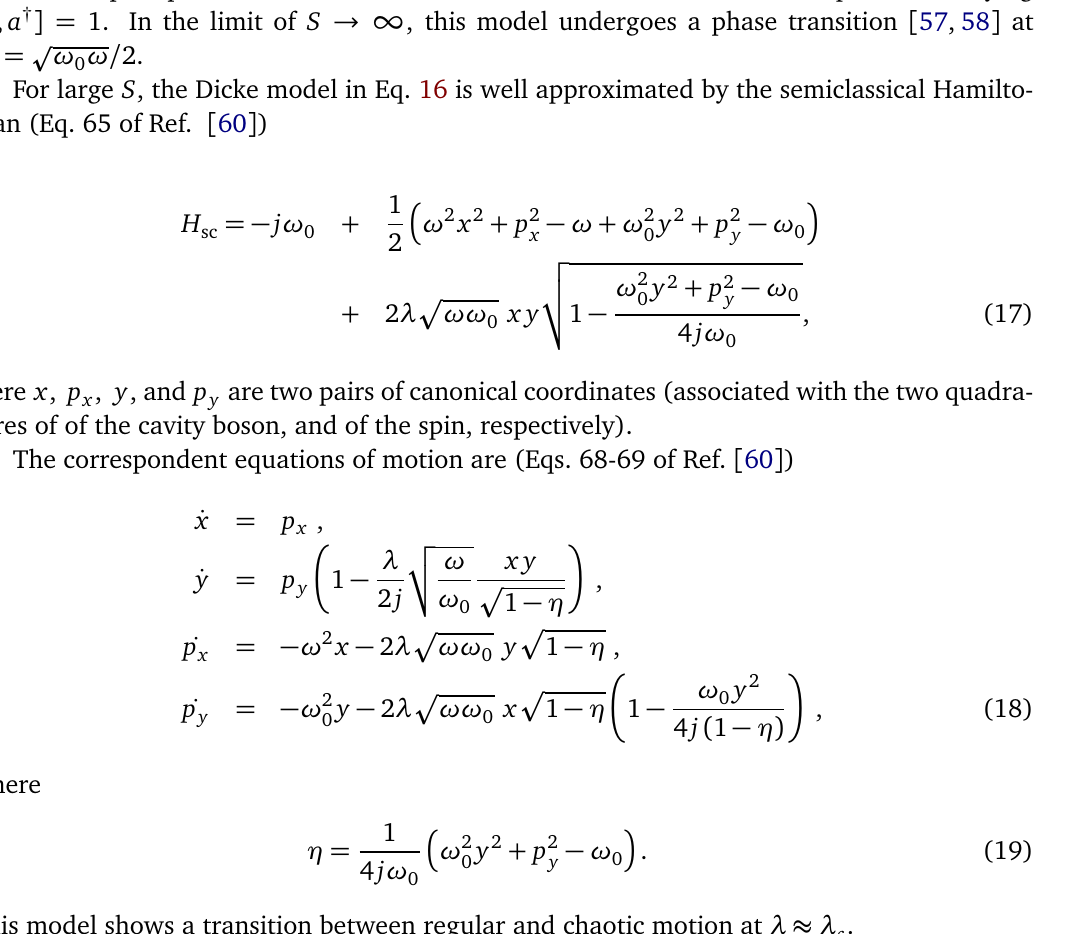
Figure 6: Steady-state distribution function of 1 − m Meshkov-Glick model, Eq. 4. The probability function of this quantity diverges as (cid:112) 1 − m (dashed line) on both sides of the x